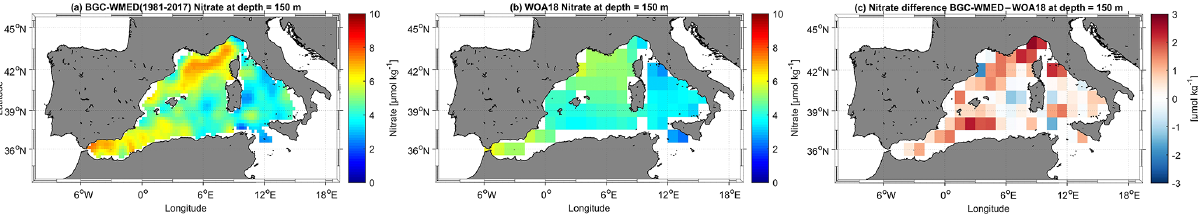
Figure 11. (a) BGC-WMED (1981–2017) nitrate climatological field at 150m depth; (b) WOA18 nitrate climatological field at 150m depth; (c) difference between BGC-WMED and WOA18 nitrate fields at 150m.